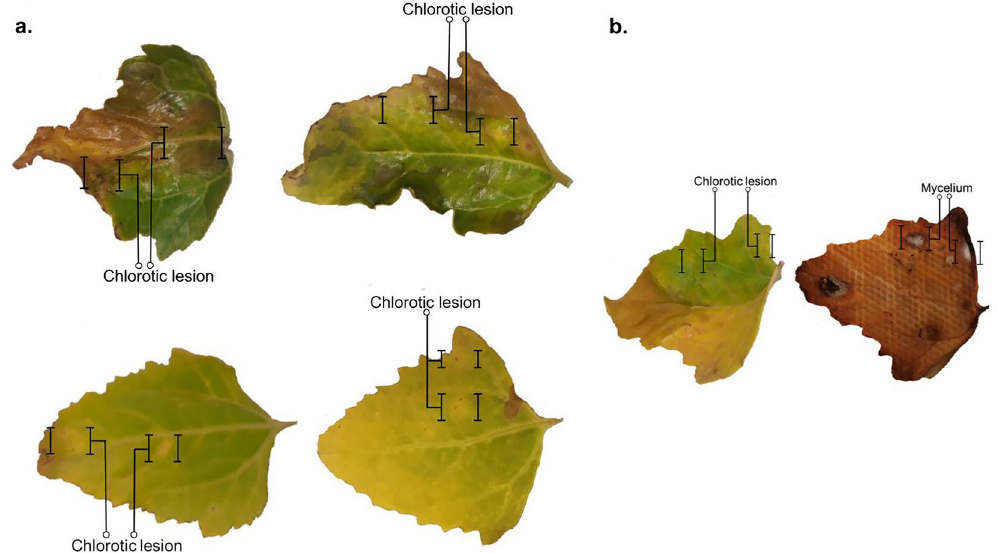
Figure 4. Lesions observed in the field crops that presented growth of Fusarium spp. ( a ) Leaves collected with different degrees of affectation. ( b ) The lesions corresponding to Fusarium spp. were determined by the growth of the mycelium, after seven days of